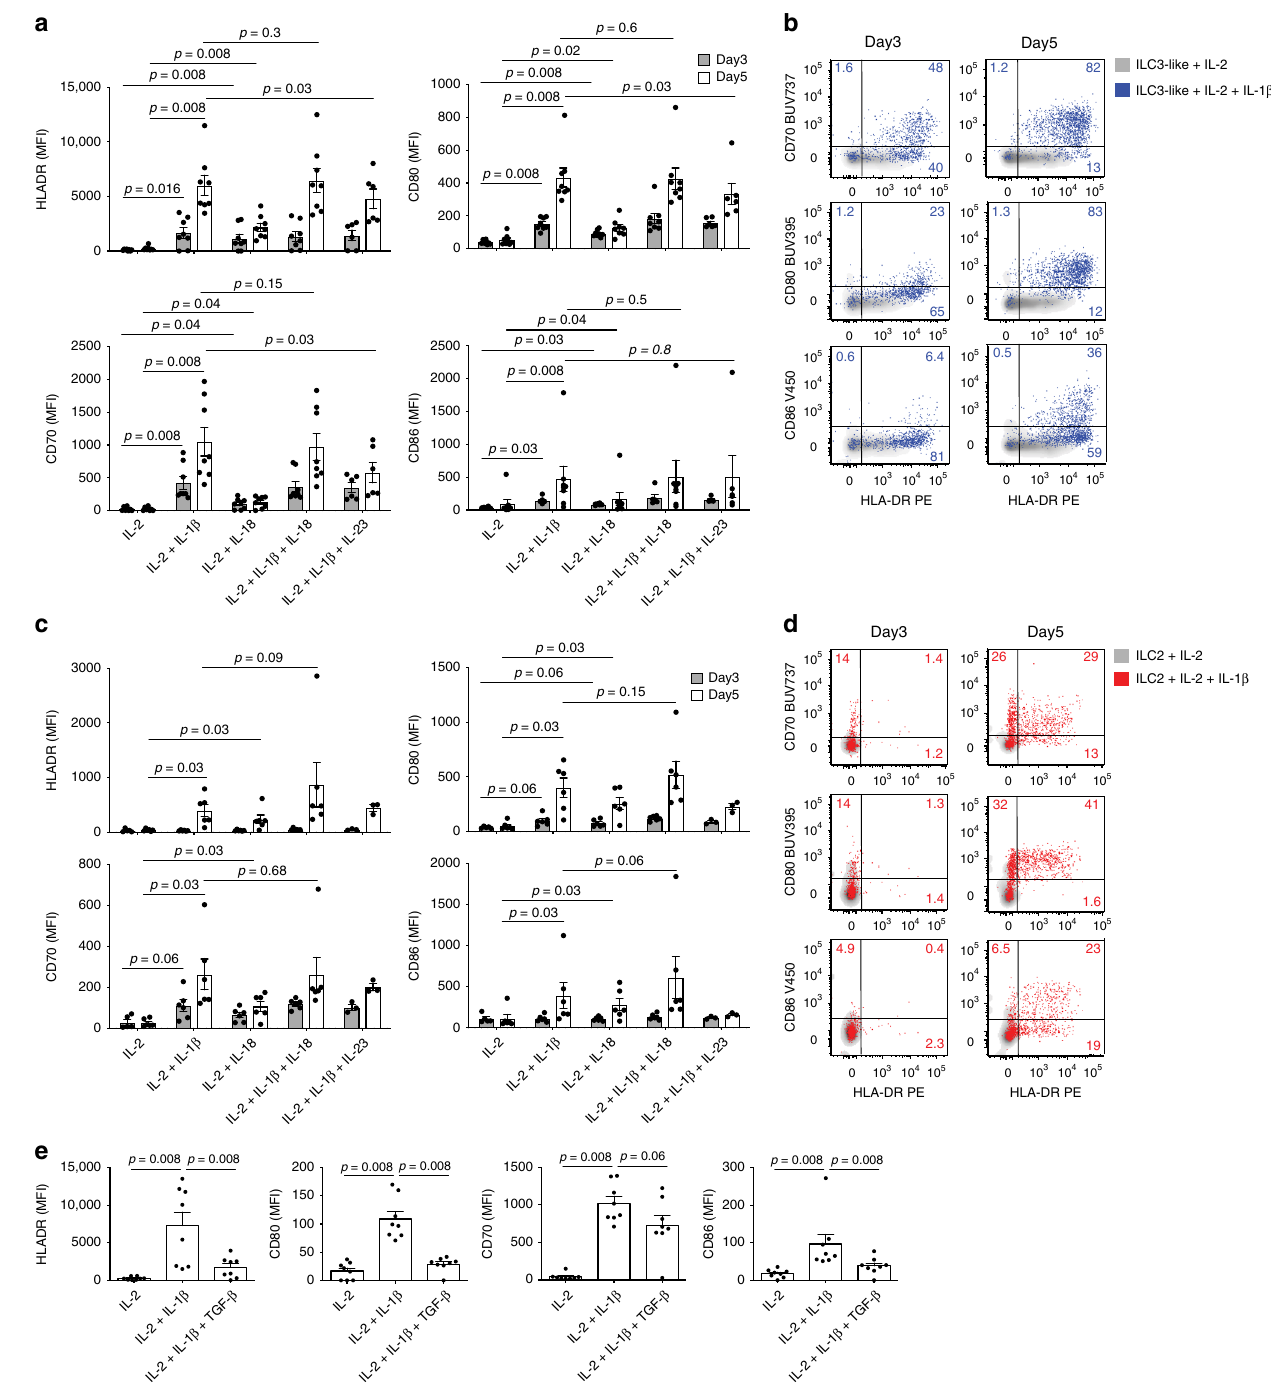
Fig. 4 HLA-DR and co-stimulatory molecule expression on PB ILCs in response to cytokine treatment. a , c Summarized data and b , d representative fl ow cytometric dot plots of HLA-DR, CD86, CD80, and CD70 expression by sort-puri fi ed ILC3-like cells ( a , b ) and ILC2 ( c , d ) after 3 and 5 days of treatment with the indicated cytokine combinations. N (donors) = 8 (for ILC3-like cells) and 6 (for ILC2). Due to limited cell numbers, we could not generate data for all conditions for every donor; source data are provided as a source data fi le. e HLA-DR, CD86, CD80, and CD70 expression by sort-puri fi ed ILC3-like cells after 5 days of IL-2, IL-2 plus IL-1 β , or IL-2 plus IL-1 β , and TGF- β treatment. N (donors) = 8; bars and error bars indicate mean and SEM; statistical signi fi cance was assessed using two-sided Wilcoxon matched-pairs signed rank test. Source data are provided as a source data fi